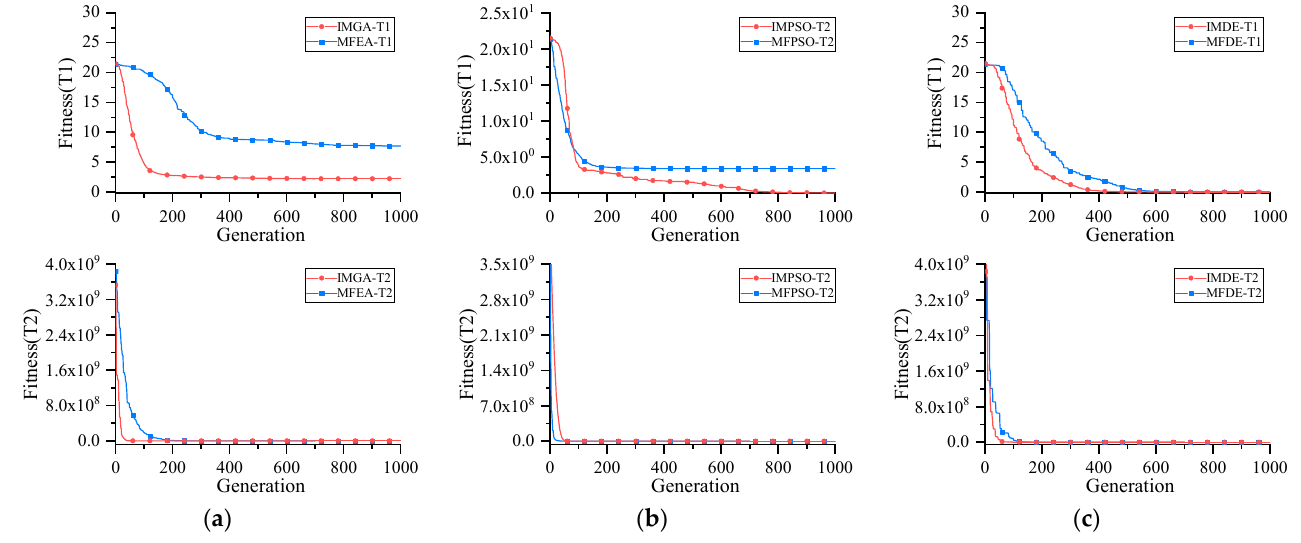
Figure 4. Convergence traces of IMTO and MFO on multitasking problem P 5 in test suite 1. ( a ) Con- vergence traces of IMGA and MFEA, ( b ) Convergence traces of IMPSO and MFPSO, and ( c ) Con- vergence traces of IMDE and MFDE.